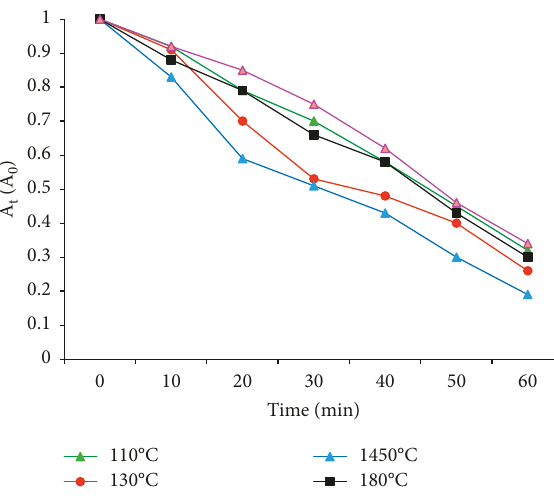
Figure 4: Degradation rate at different temperatures. Table 3: Powders at different times.